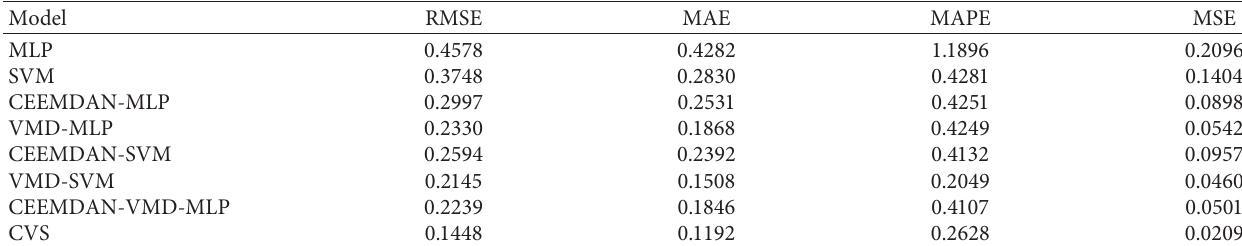
Table 3: Comparison of the evaluation metrics of the CVS model with other models in the testing period. Model